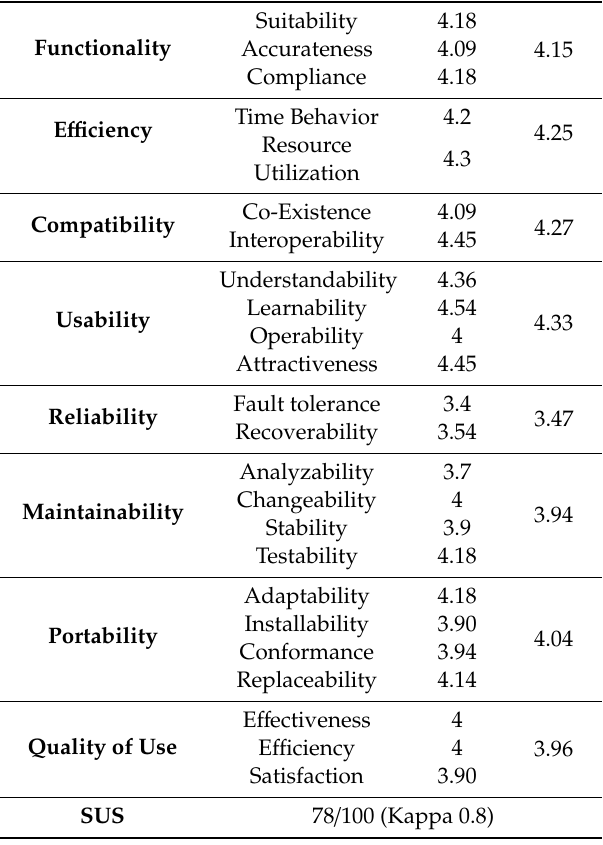
Table 1. The results for the various evaluation